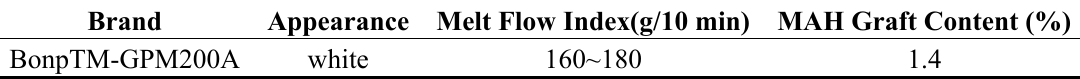
Table 2. Properties of maleic anhydride drafted